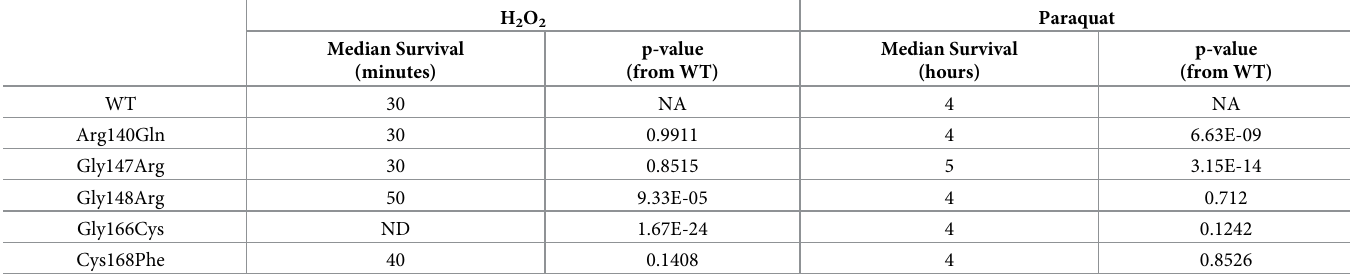
Table 2. Oxidative stress resistance in nfu-1 mutants. Median survival and curve difference from WT for both H 2 O 2 and Pq exposure assays (Fig 4F and 4G). P-values calculated with Log-rank (Mantle-Cox) analysis with Bonferroni correction for multiple comparisons. ND: Not